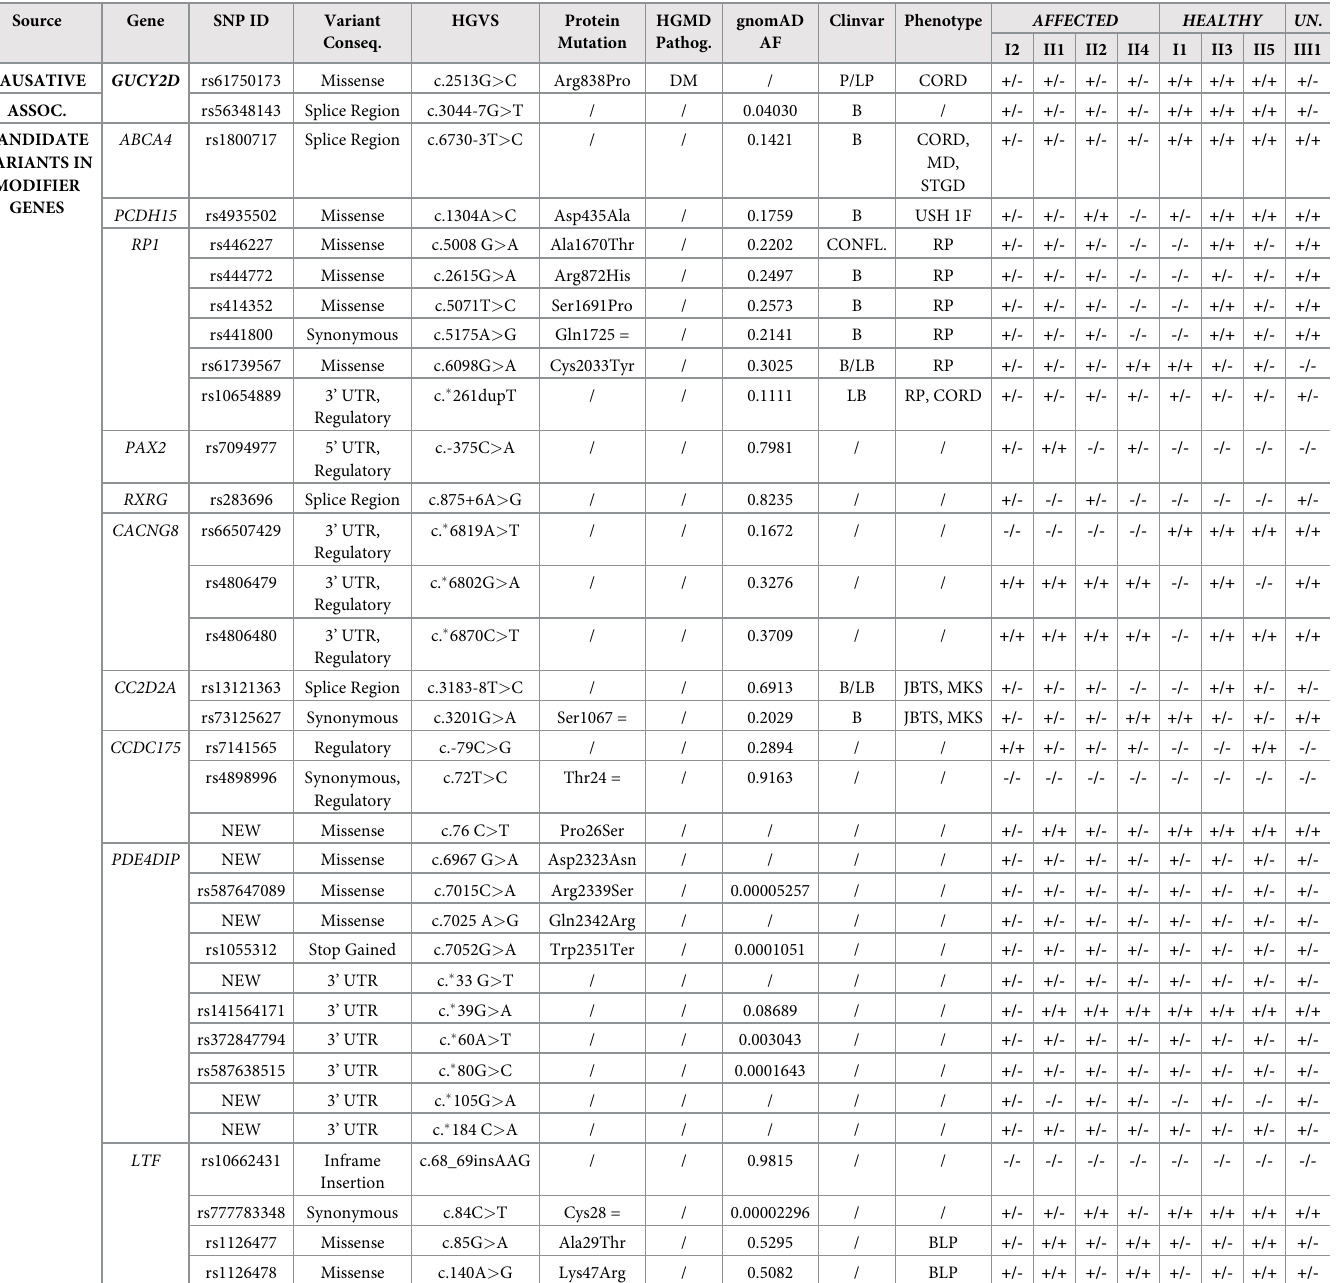
Table 2. Preliminary candidate variants genotyping and distribution through the members of the reported family. Source